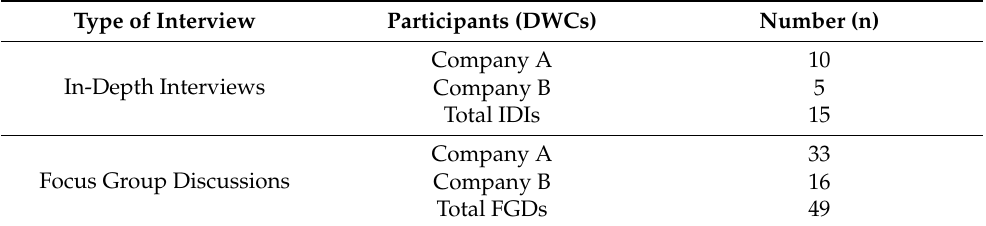
Table 1. Categories and number of qualitative interviews conducted. Type of